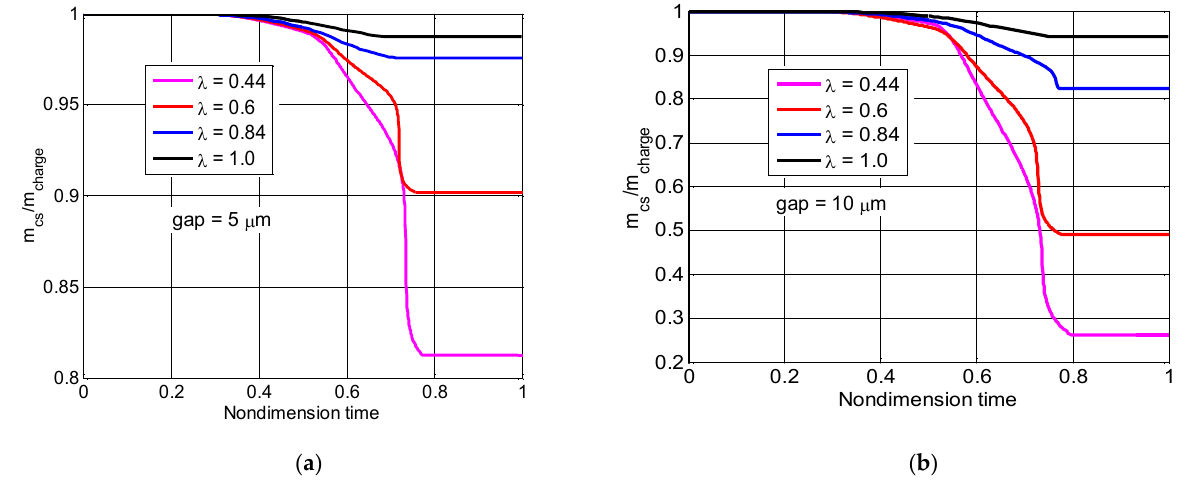
Figure 7. The effect of mass percentage in the nondimensional time cycle for different size factors ( a ) the 5 μm seal gap, ( b ) the 10 μm seal gap.